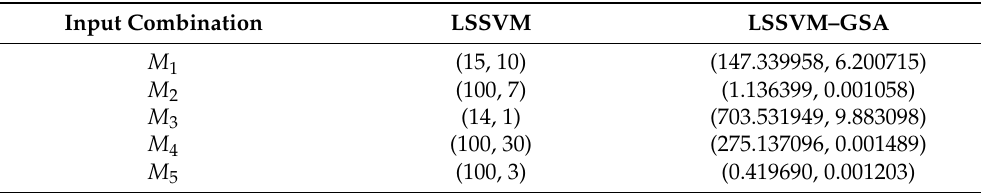
Table 4. Hyper-parameters ( γ , σ ) of LSSVM for each input combination.